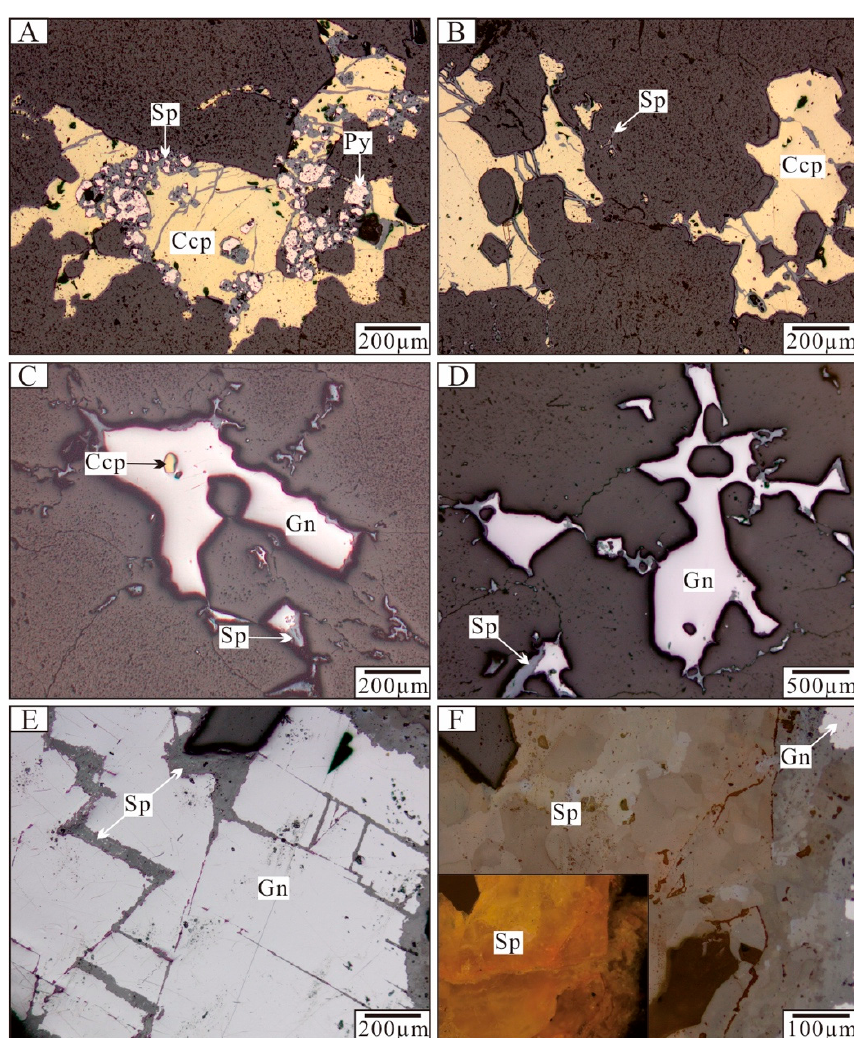
Figure 4. Photomicrographs showing important mineral assemblages of the Kuergasheng Pb–Zn deposit. ( A ) Pyrite replaced by an aggregate of chalcopyrite and sphalerite; ( B ) Chalcopyrite replaced by sphalerite; ( C ) Poikilitic texture; ( D ) Reaction rim texture; ( E ) Sphalerite grows along fissures in galena. ( F ) Sphalerite with brown internal reflection color. Abbreviations: Py (pyrite); Ccp (chalcopyrite); Gn (galena); Sp (sphalerite).